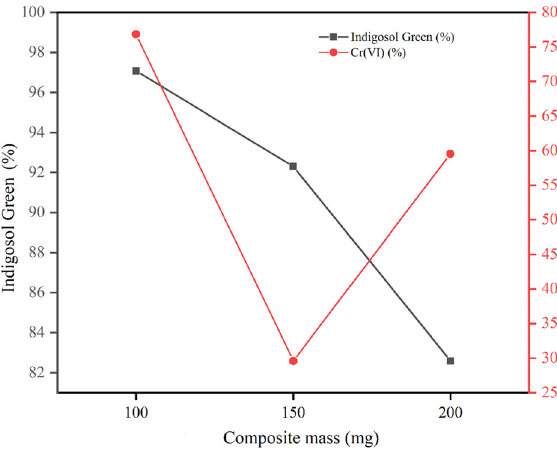
Figure 6: E ff ect of pH for the removal of indigisol green and Cr ( VI ) from aqueous solutions.